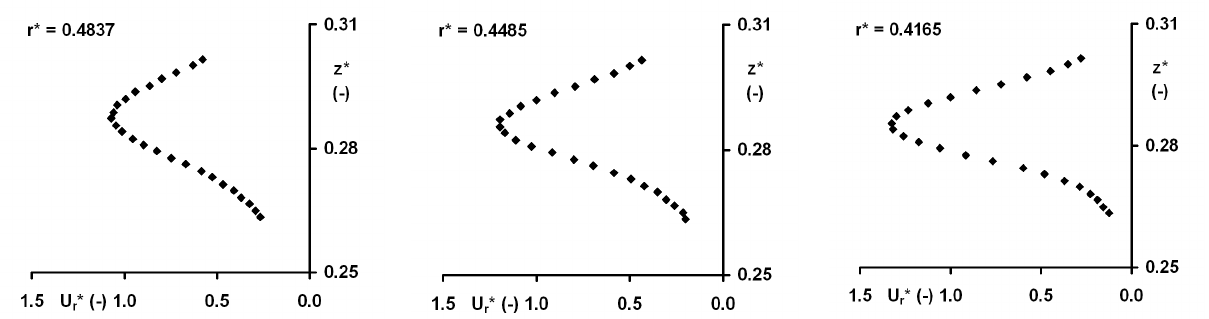
Fig. 6. Dimensionless radial mean velocity profiles )/( NDU